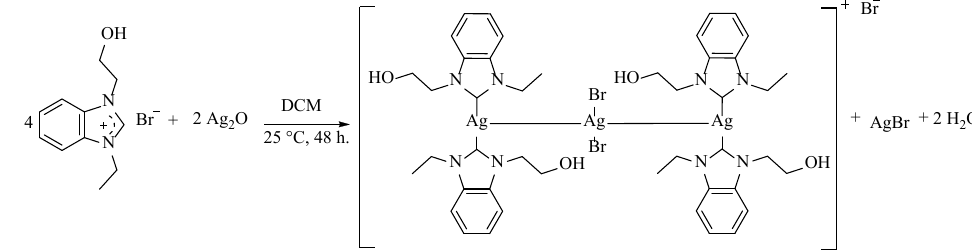
Table 1. Crystal data and experimental details for the Ag-NHC complex 1 .